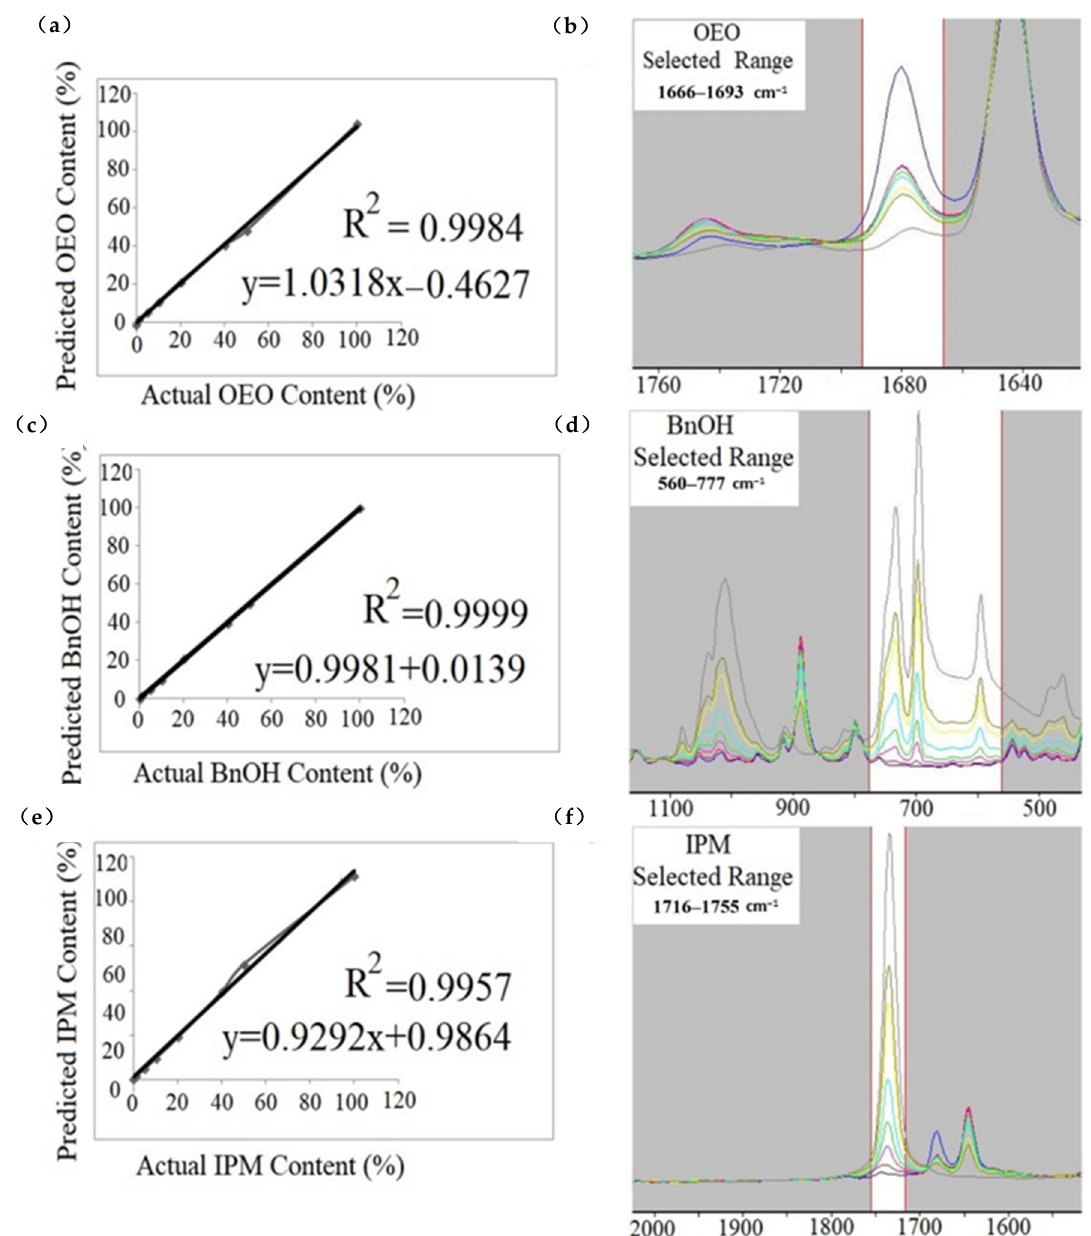
Figure 3. Cross-validation r (partial least squares regression (PLSR)—raw spectra): actual versus predicted values and selected calibration ranges ( a ) OEO adulteration in LEO, ( b ) selected calibration range for OEO adulteration in LEO, ( c ) BnOH adulteration in LEO, ( d ) selected calibration range for BnOH adulteration in LEO, ( e ) IPM adulteration in LEO, ( f ) selected calibration range for IPM adulteration in